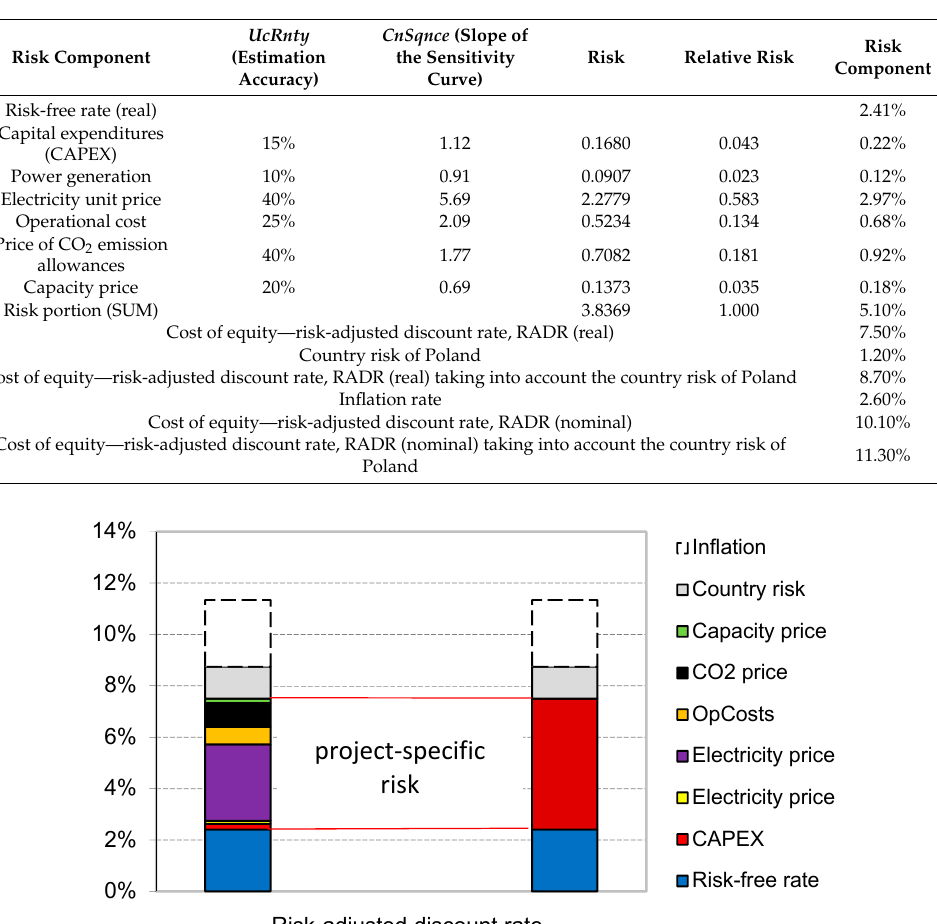
Table 1. Analysis of risk components within a risk-adjusted discount rate of coal-fired power projects in Polish conditions.